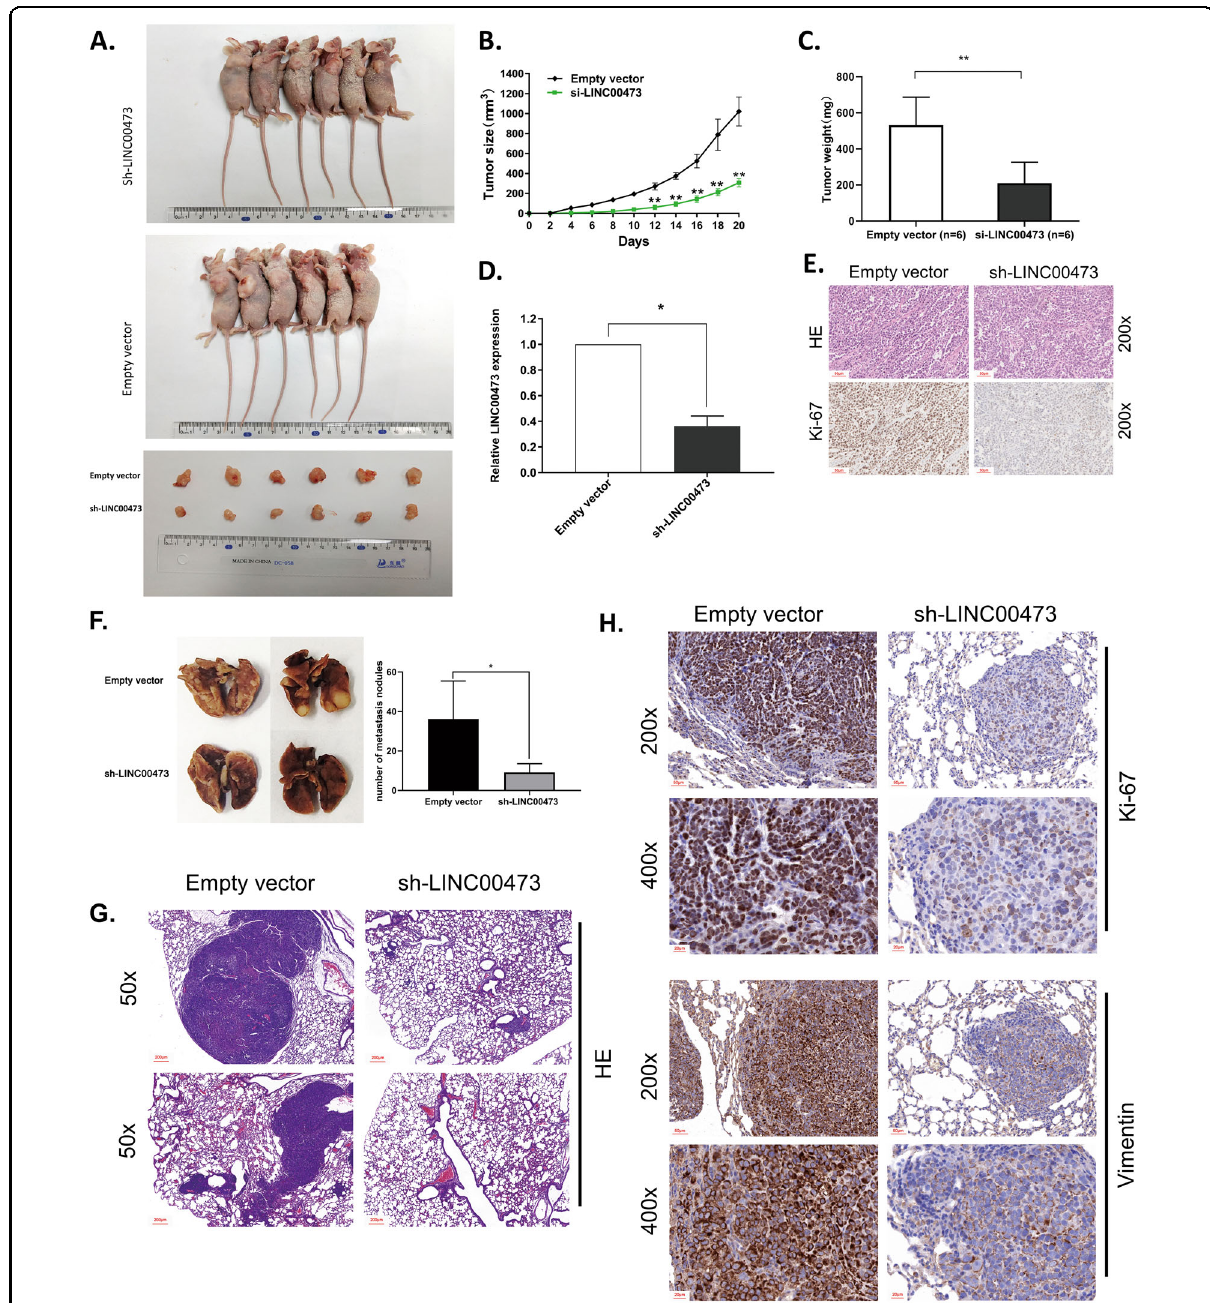
Fig. 4 Effects of LINC00473 on GC tumorigenesis and metastasis in vivo. A Empty vector or sh-LINC00473 was transfected into BGC823 cells, which were injected into the BALB/c-nude mice ( n = 6), respectively. B Tumor volumes were calculated after injection every 3 days. Points, mean ( n = 6); bars indicate SD. C Tumor weights were represented as means of tumor weights ± SD. D QRT-PCR was performed to detect the average expression of LINC00473 in xenograft tumors ( n = 6). E H&E staining and IHC staining with antibodies against ki-67 were used in the tumor sections. Original magni fi cation, ×200. Scale bar: 50 µm. F and G Lungs from mice in each experimental group transfected with sh-LINC00473 or empty vector, with the numbers of tumor nodules on lung surfaces represented as mean ± SD, are shown. Original magni fi cation, ×50. Scale bar: 200 µm. H Lung sections under H&E staining and IHC staining of antibodies against ki-67 and vimentin were showed. Upper: Original magni fi cation, ×200. Scale bar: 50 µm; Lower: Original magni fi cation, ×400. Scale bar: 20 µm. The scale bars were indicated in the fi gure. * P < 0.05, ** P <